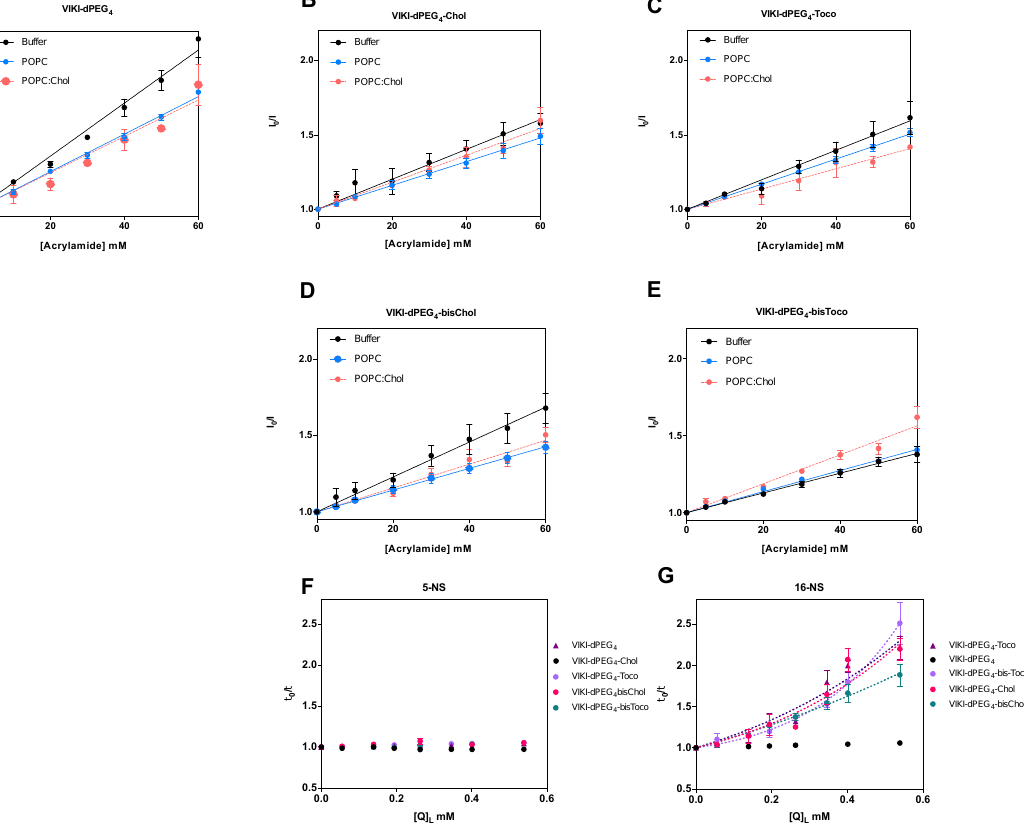
Figure 2. Accessibility of the peptide to the aqueous medium. Fluorescence quenching by acrylamide of VIKI series ( A – E ). Lipid compositions tested were pure POPC and POPC:Chol (2:1), using 5 µ M peptide and 0.5 mM total lipid. Continuous and dashed lines are fittings of the Stern–Volmer equation. Fluorescence quenching by 5-NS ( F ), and 16-NS ( G ), determined by time-resolved fluorescence spectroscopy in the presence 0.5 mM POPC LUV. Dashed lines are fittings of Equation (3). All values are mean values from at least three independent experiments.